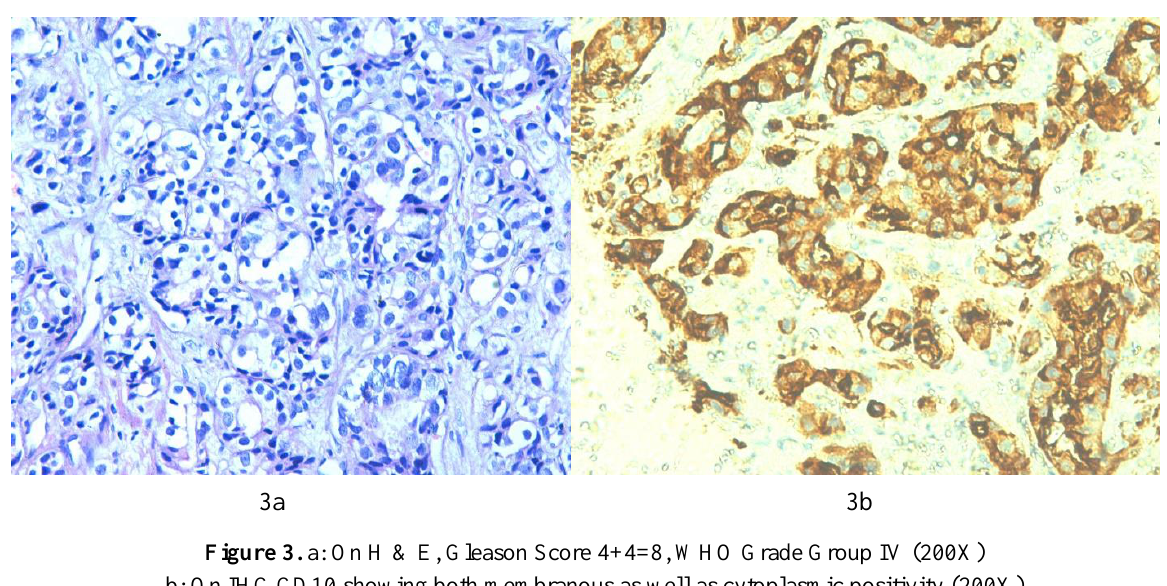
Figure 3. a: On H & E, Gleason Score 4+4=8, WHO Grade Group IV (200X) b: On IHC CD10 showing both membranous as well as cytoplasmic positivity